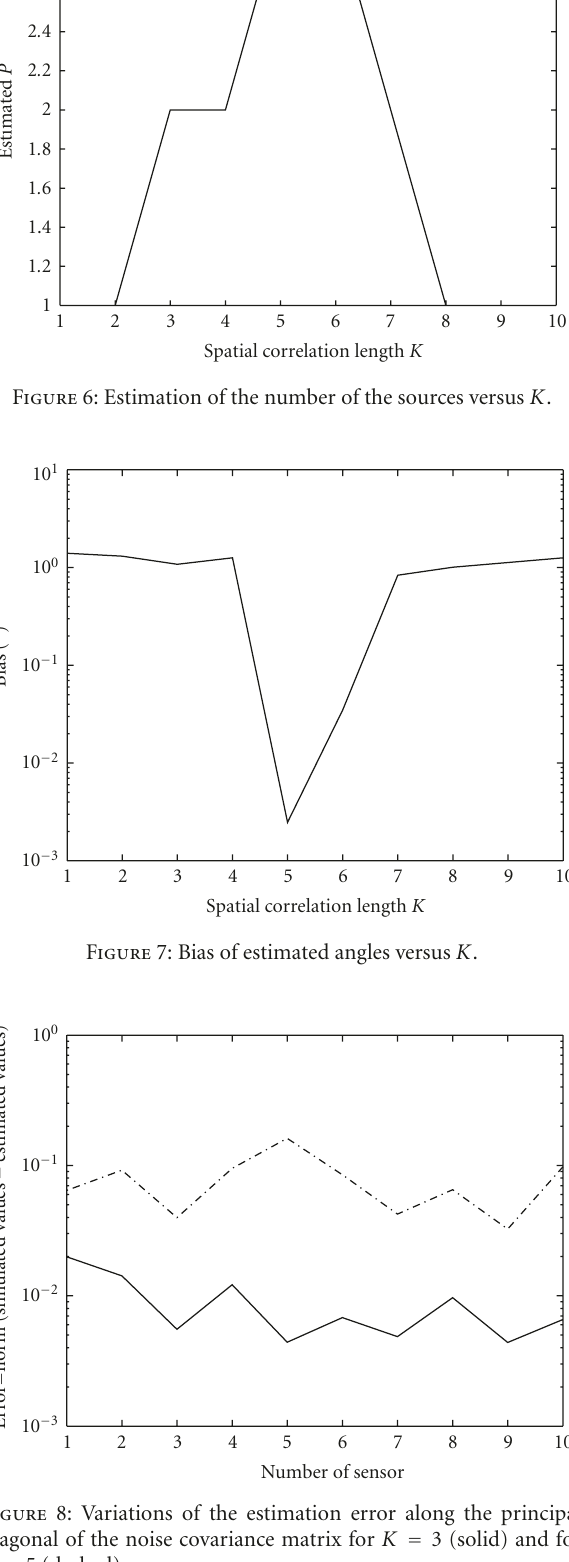
Figure 8: Variations of the estimation error along the principal diagonal of the noise covariance matrix for K = 3 (solid) and for K = 5